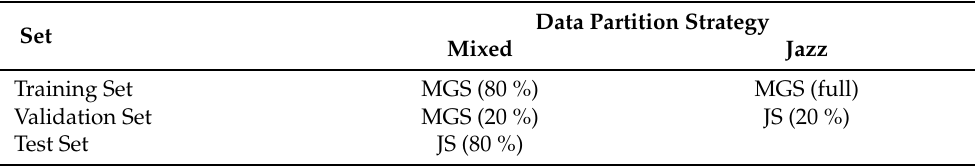
Table 2. Two data partition strategies to split the two datasets introduced in Table 1 into training, validation, and test sets. The validation sets are used for the parameter optimization (Section 5.1) and the test set is used for the final evaluation study (Section 5.2).